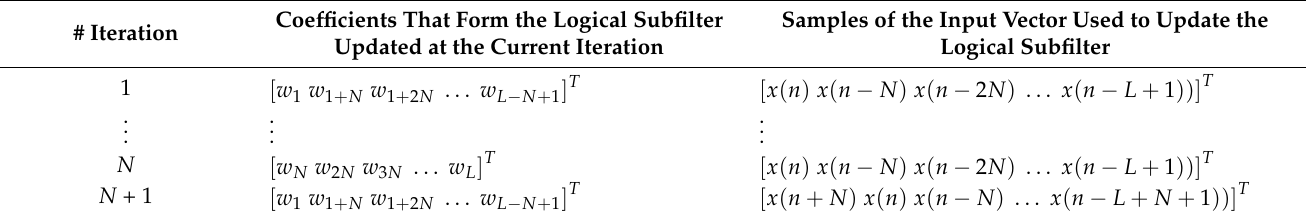
Samples of the Input Vector Used to Update